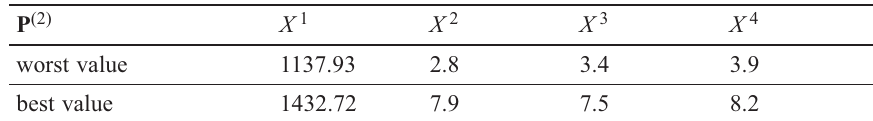
Table 2. Potency matrix P